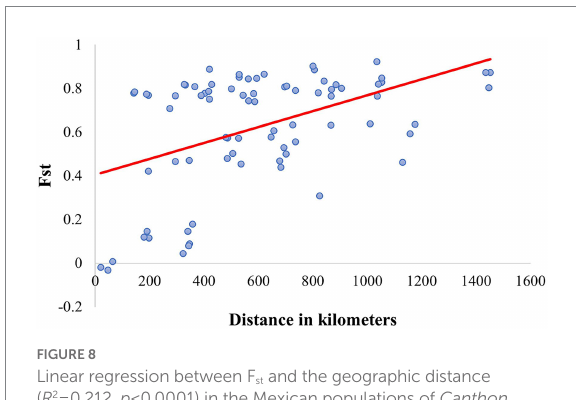
FIGURE 8 Linear regression between F st and the geographic distance ( R 2 = 0.212, p < 0.0001) in the Mexican populations of Canthon cyanellus . This analysis was carried out based on the paired linear geographic distances between populations and the paired F st values were obtained with DnaSP v6.12.03 (Rozas et al.,